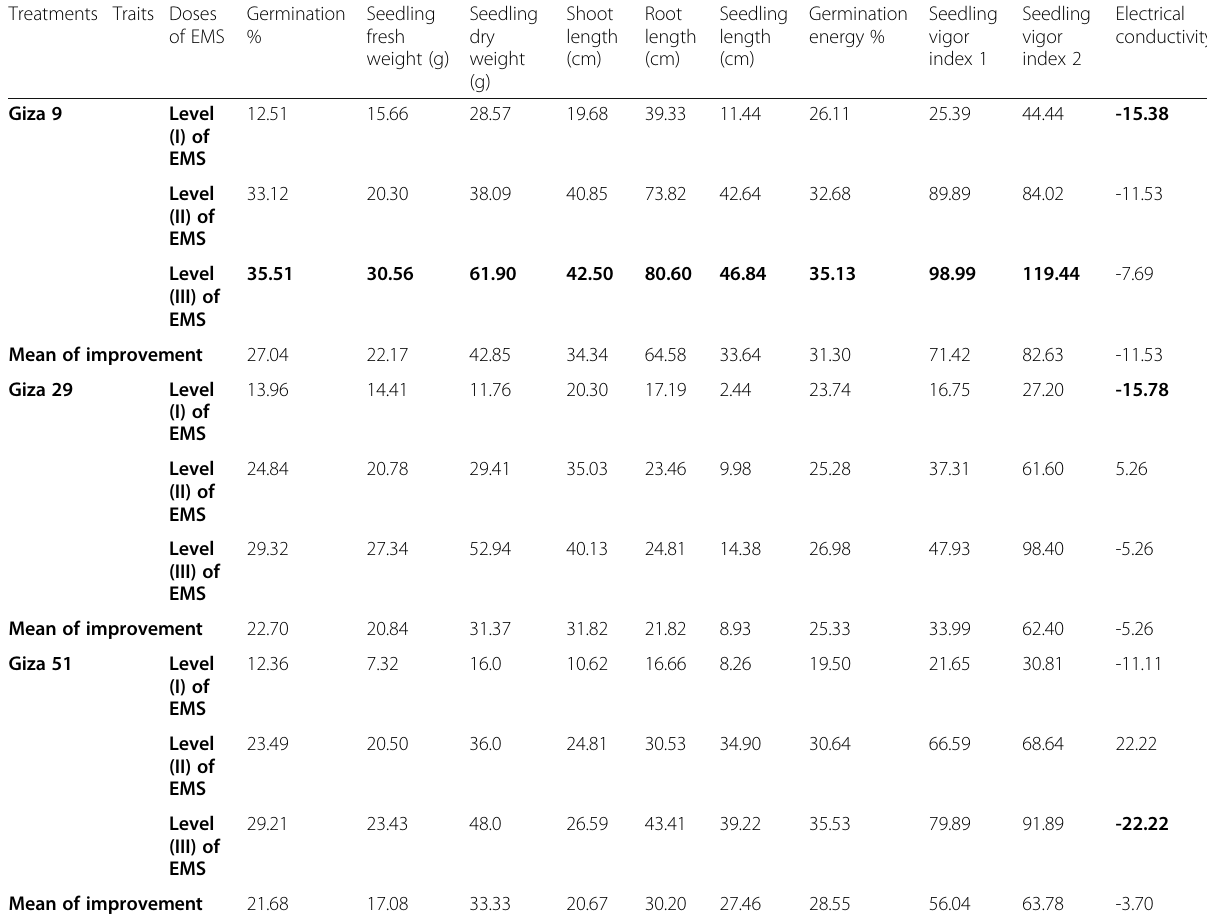
Table 2 Percentages of positive and negative values for lentil M2 seedling traits under control and ethyl methane sulfonate (EMS) Treatments Traits Doses Germination of EMS